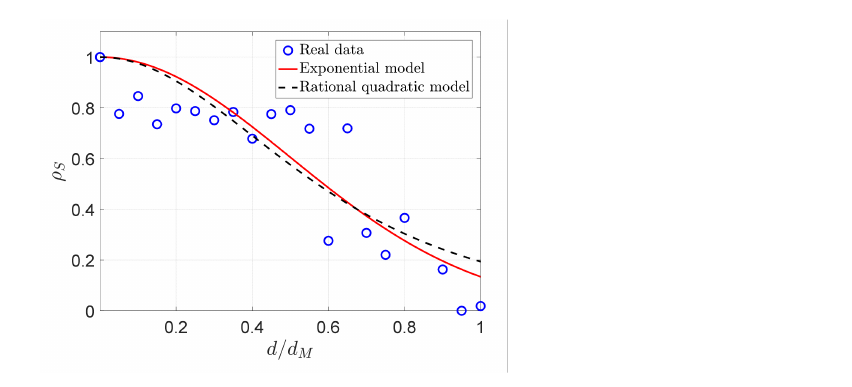
Figure 3. The comparison between the exponential model and the rational quadratic